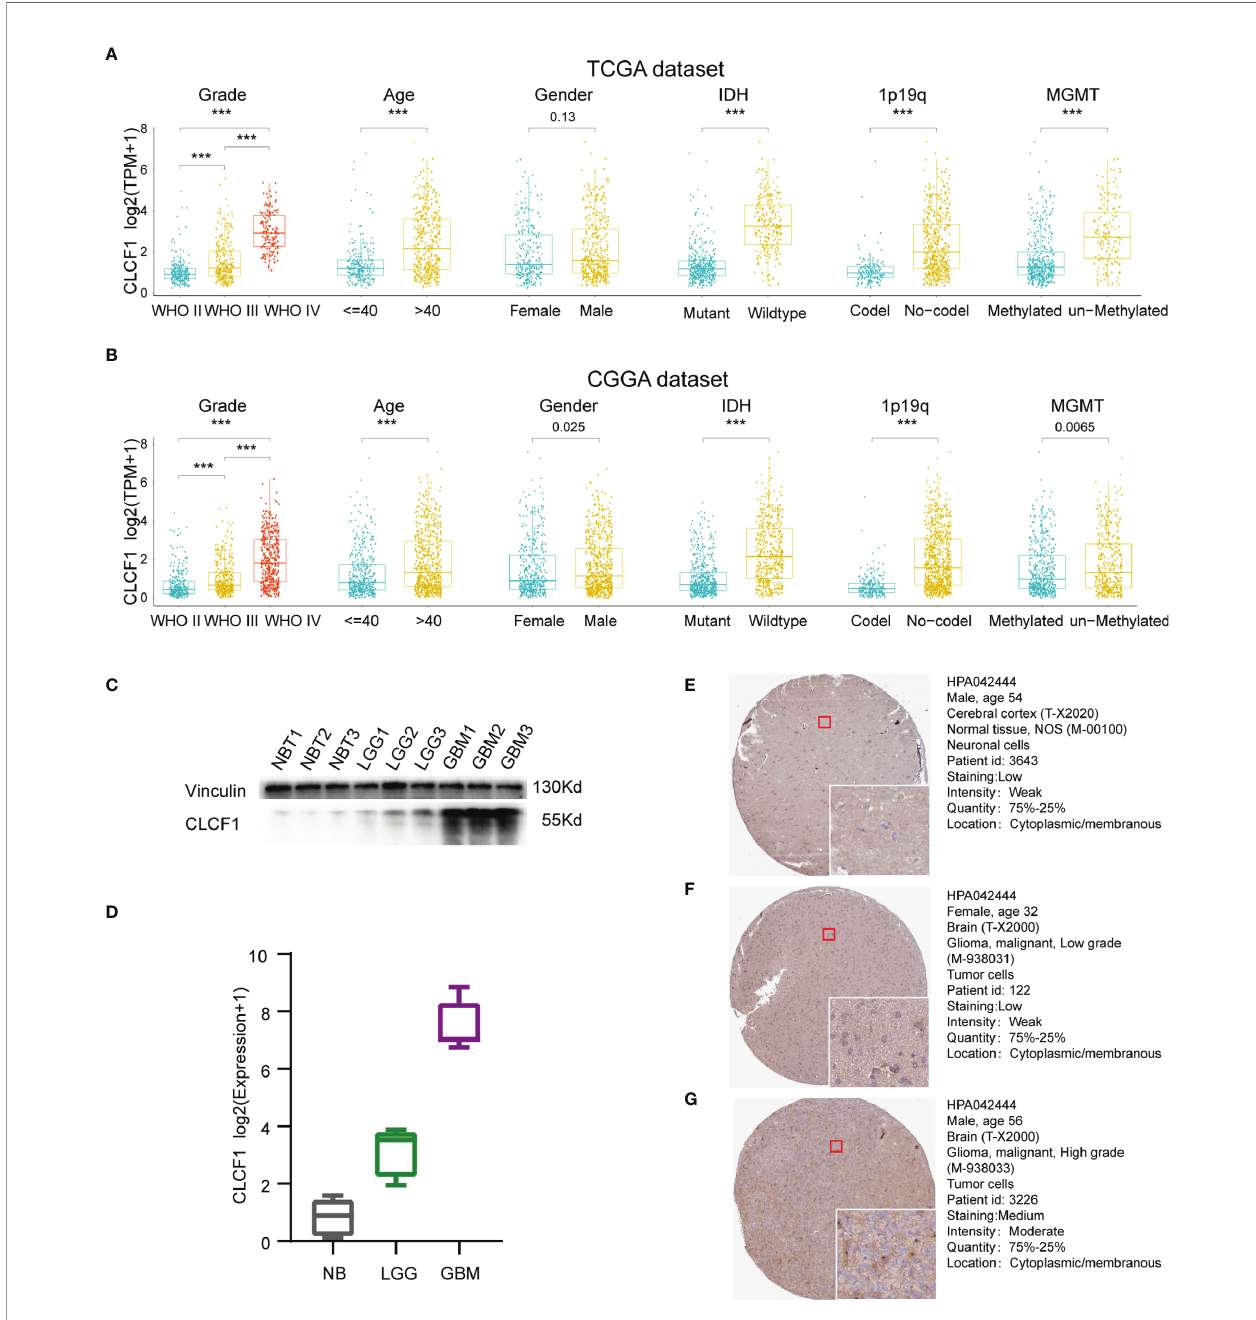
FIGURE 3 | Correlation between CLCF1 and WHO grade, age, sex, IDH mutation status, 1p/19q co-deletion status, and MGMT promoter methylation in (A) TCGA and (B) CGGA datasets, Signi fi cance: ***P < 0.001; (C) Western blotting analysis; (D) qRT-PCR analysis; IHC staining for CLCF1 in (E) normal brain tissue, (F) LGG tissue, and (G) GBM